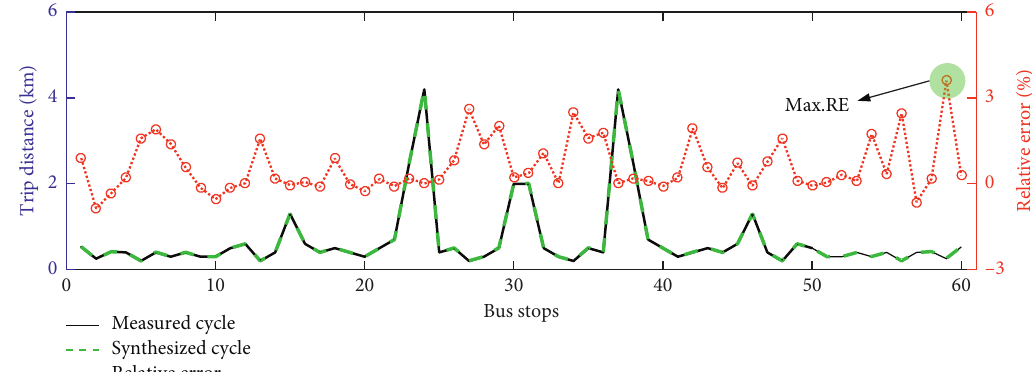
Figure 10: Distance comparison of the adjacent bus stops interval.